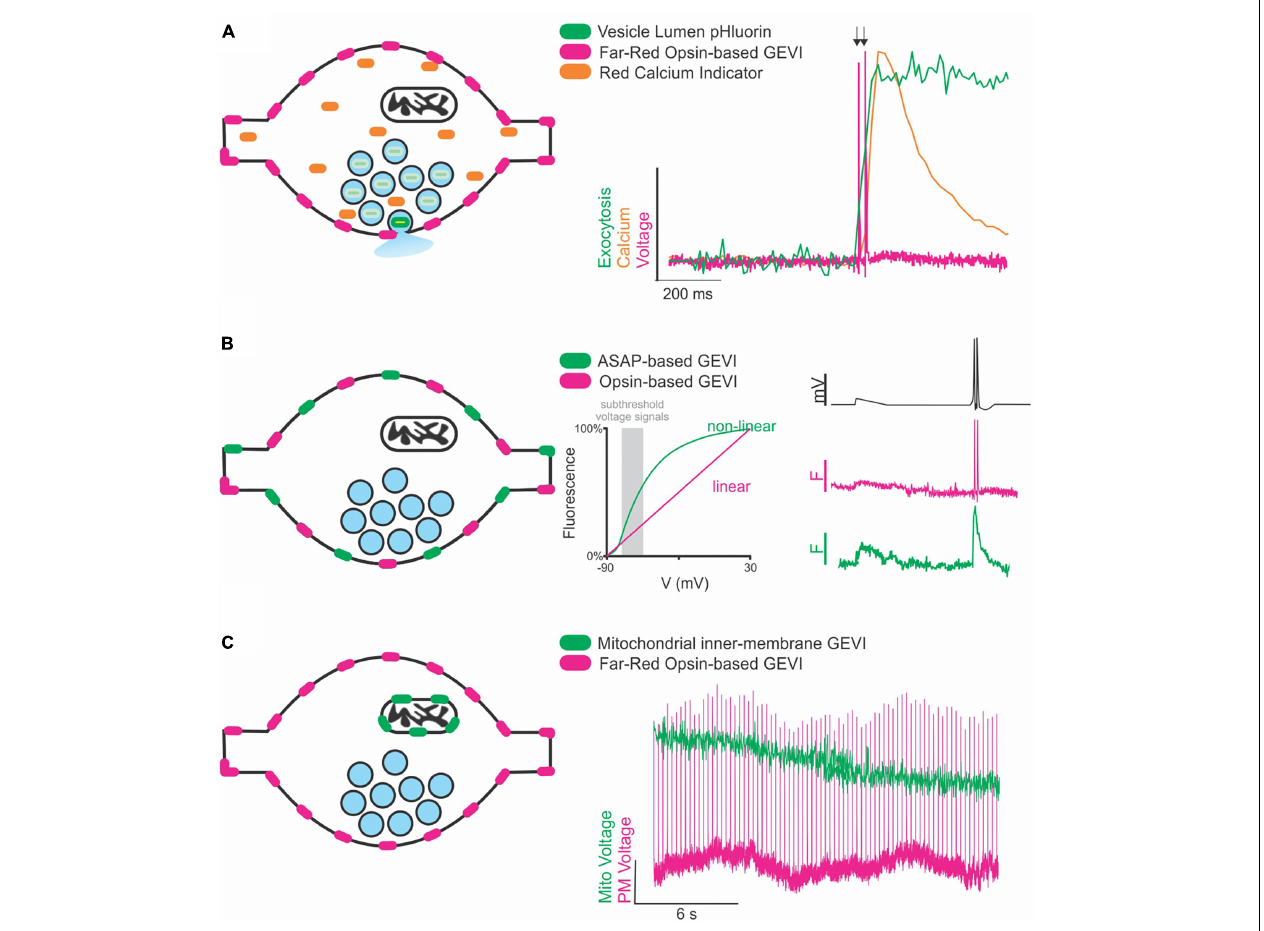
FIGURE 1 | Future directions of GEVIs to explore synaptic transmission. (A) Cartoon of a synapse expressing a far-red rhodopsin-based GEVI on the membrane and a cytosolic red Ca 2 + indicator. Vesicles (blue circles) contain pHluorin, a vesicular lumen-targeted pH-sensitive reporter of exocytosis ( left ). Theoretical traces ( right ) demonstrating recording of two single AP stimulations (arrows) superimposed with theoretical fluorescence traces of the Ca 2 + and exocytosis response in the same cell. (B) Cartoon of a synapse expressing two spectrally separate, membrane-targeted GEVIs ( left ). Subthreshold events (gray box, center ) are in a voltage range better detected with large fluorescence changes by a non-linear indicator than a linear indicator. A theoretical voltage trace ( right, top ) of a subthreshold event followed by two single AP stimulations. Theoretical fluorescence traces of the linear ( middle ) and non-linear ( bottom ) indicators demonstrate how combining indicators could help resolve both sub- and suprathreshold events in the same cell. (C) Cartoon of a synapse expressing a membrane-targeted far-red GEVI, and a mitochondrial-targeted green GEVI ( left ). Theoretical fluorescence traces of both indicators demonstrate simultaneous recording of mitochondrial and membrane voltage dynamics in the same